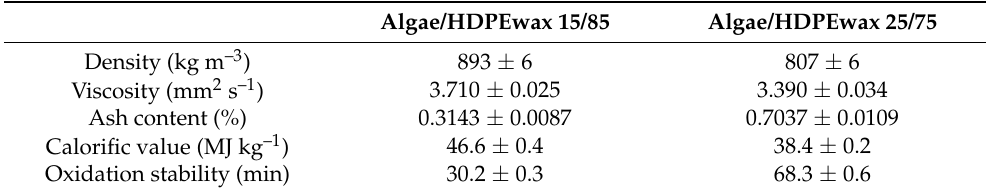
Table 5. Oil properties of two blends of algae pyrolysis oils and of HDPE wax pyrolysis oils (abbrevi- ated Algae and HDPEwax in this table and following Section